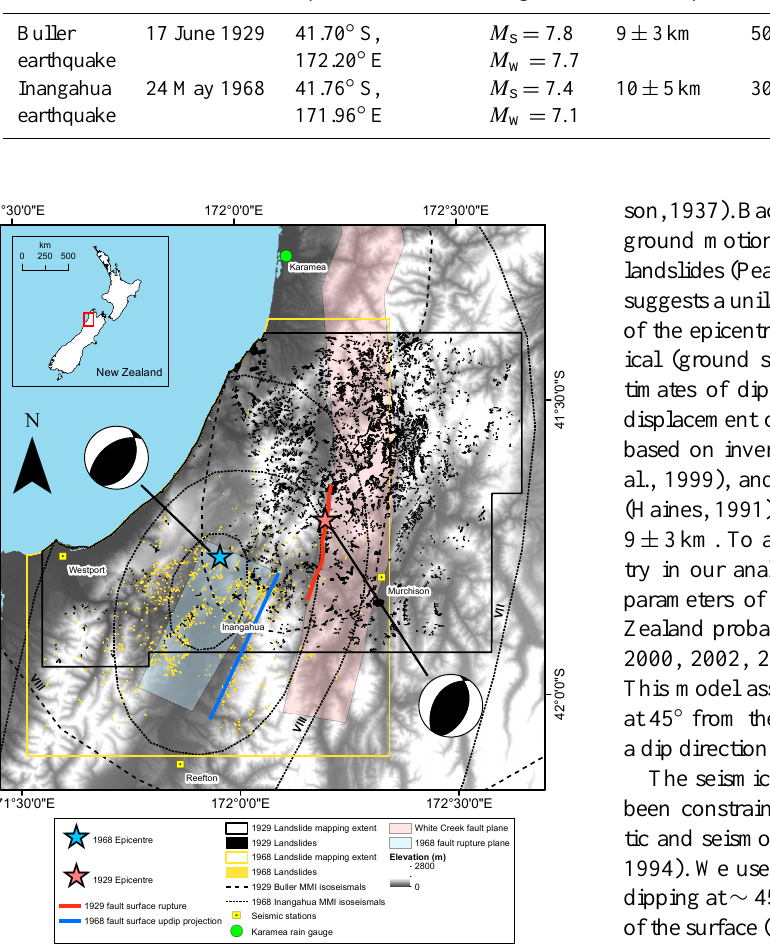
Figure 1. Elevation map of the Buller River to Karamea of the northwest South Island, New Zealand, showing the sources, ground motions and landslides triggered by the 1929 Buller and 1968 Inangahua earthquakes. Included on this map are the epicentres, focal mechanisms and fault planes of the earthquakes (Ander- son et al., 1993, 1994; Stirling et al., 2007), isoseismal contours (Dowrick, 1994; Adams et al., 1968), mapping coverage regions and earthquake-induced landslides mapped in this